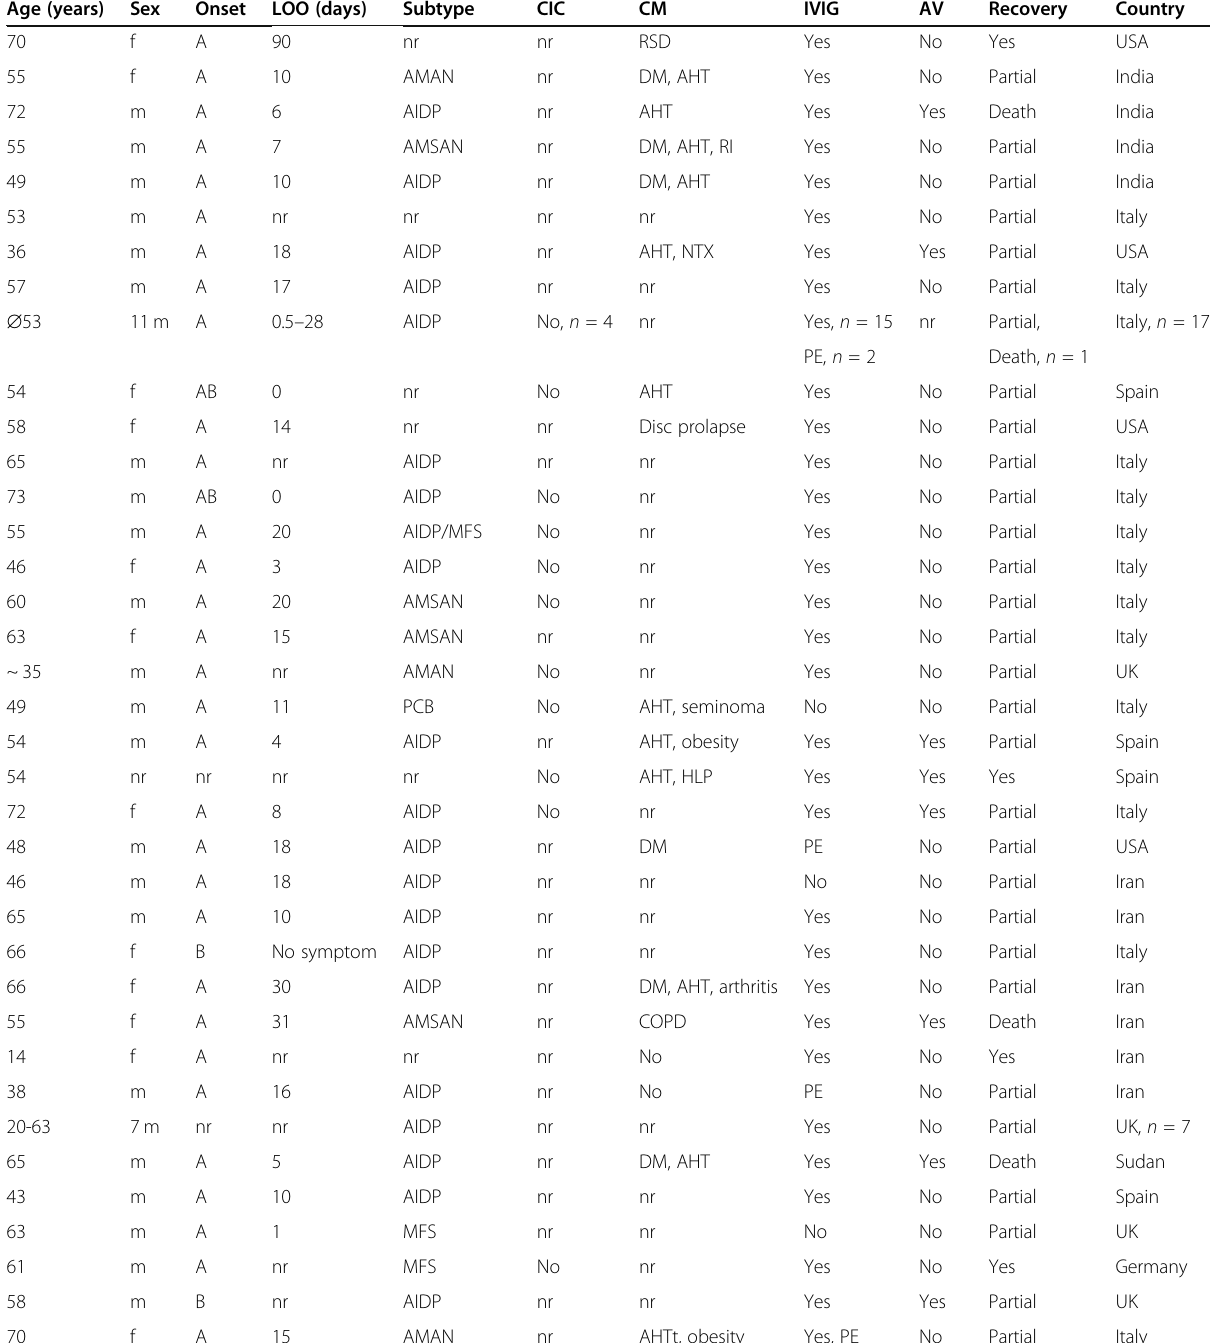
Table 1 Patients with SARS-CoV-2 associated polyradiculitis as reported by the end of December 2020 (Continued) Age